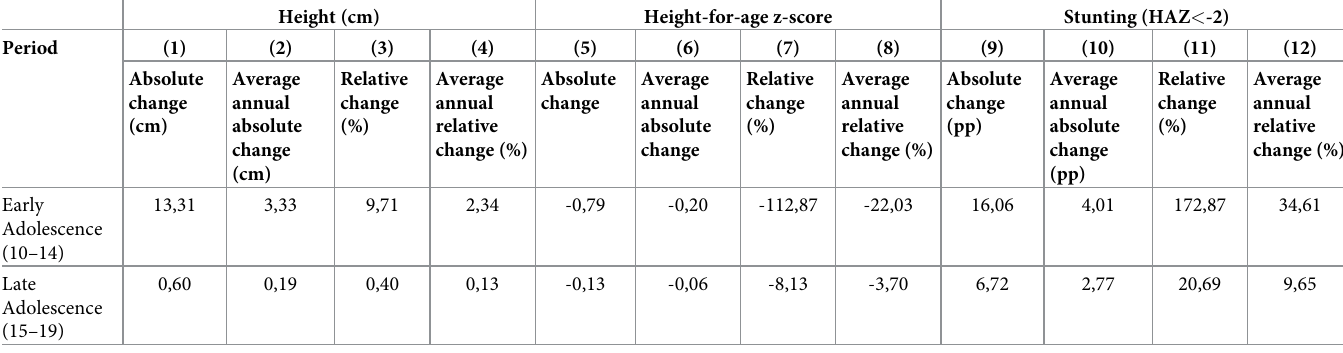
Table 1. Changes in height, height-for-age z-score, and stunting during early and late adolescence. Height (cm) Height-for-age z-score Stunting (HAZ <